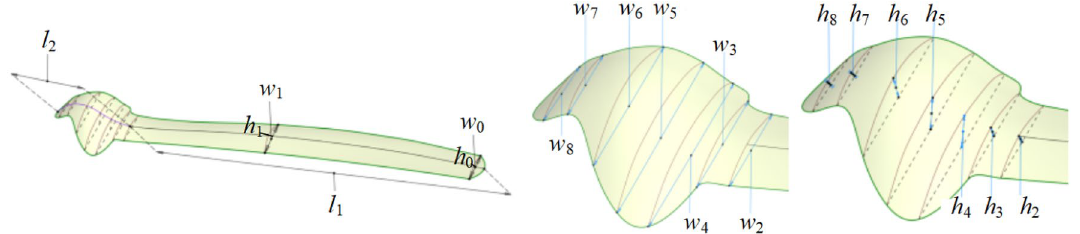
Figure 5. Size parameters of the undersurface of the eagle-shaped